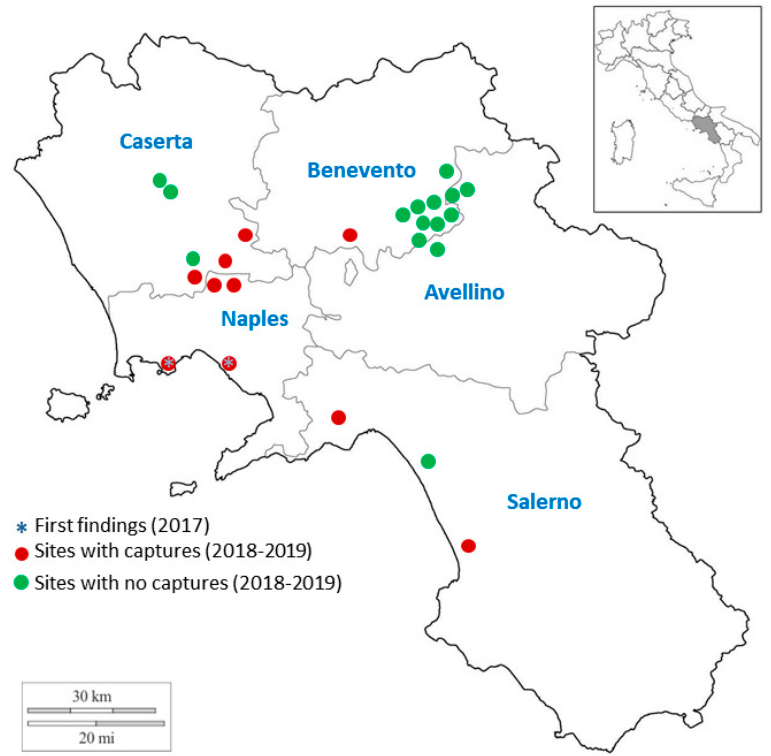
Figure 1. Distribution map for Lema bilineata in Campania (Italy) showing the first records in 2017 and subsequent samplings during 2018–2019.